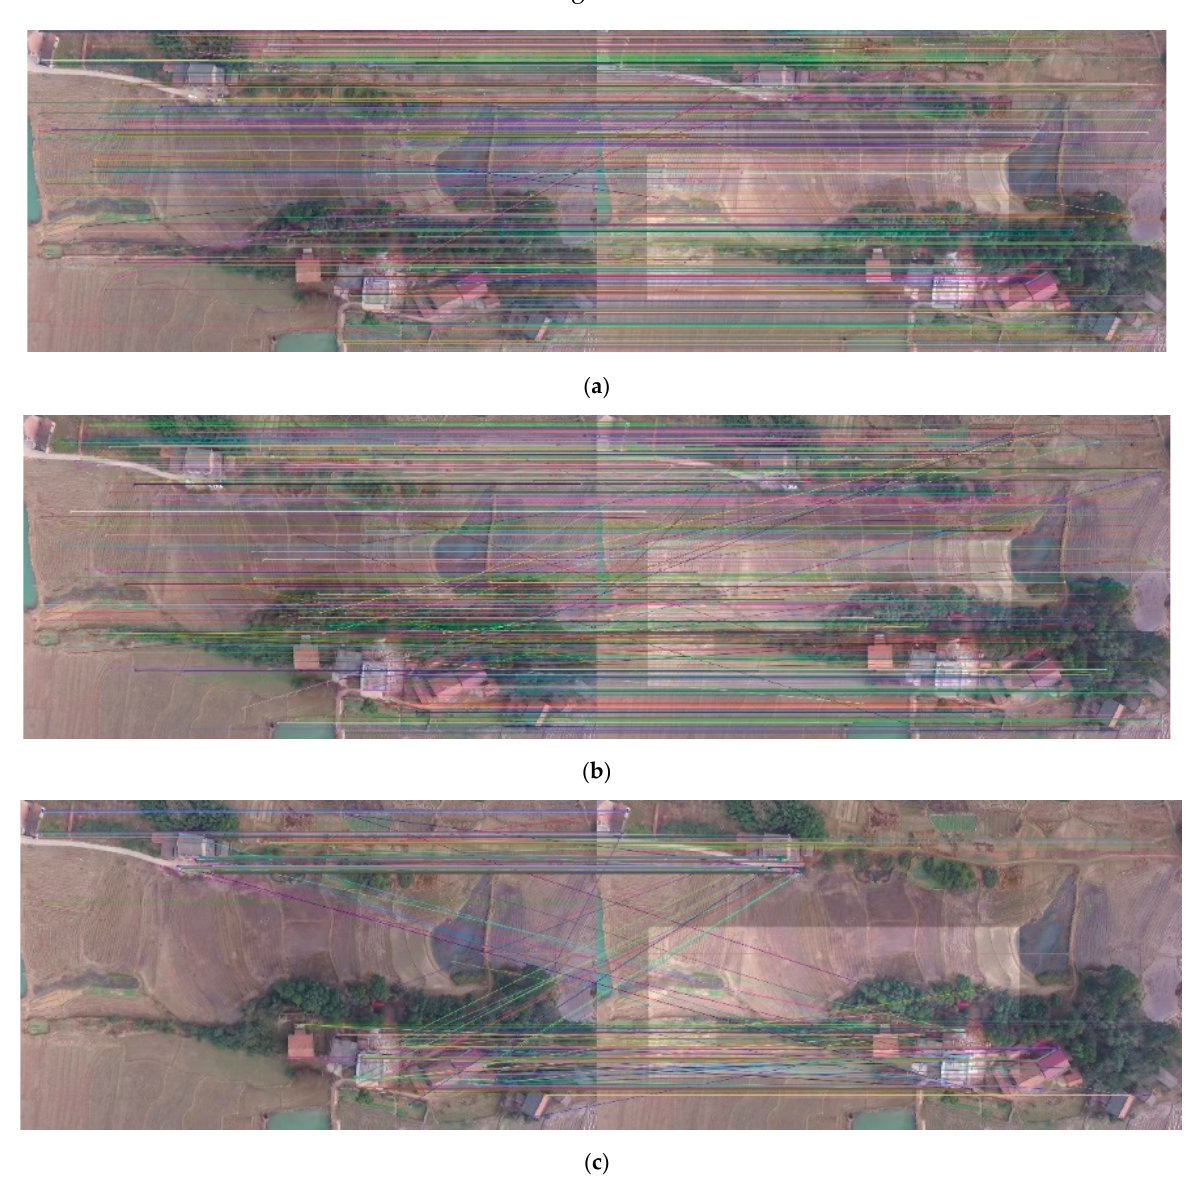
Figure 9. The matching of the original image with the image changed brightness using ( a ) SIFT feature extraction algorithm ( b ) SURF feature extraction algorithm ( c ) ORB feature extraction algorithm.